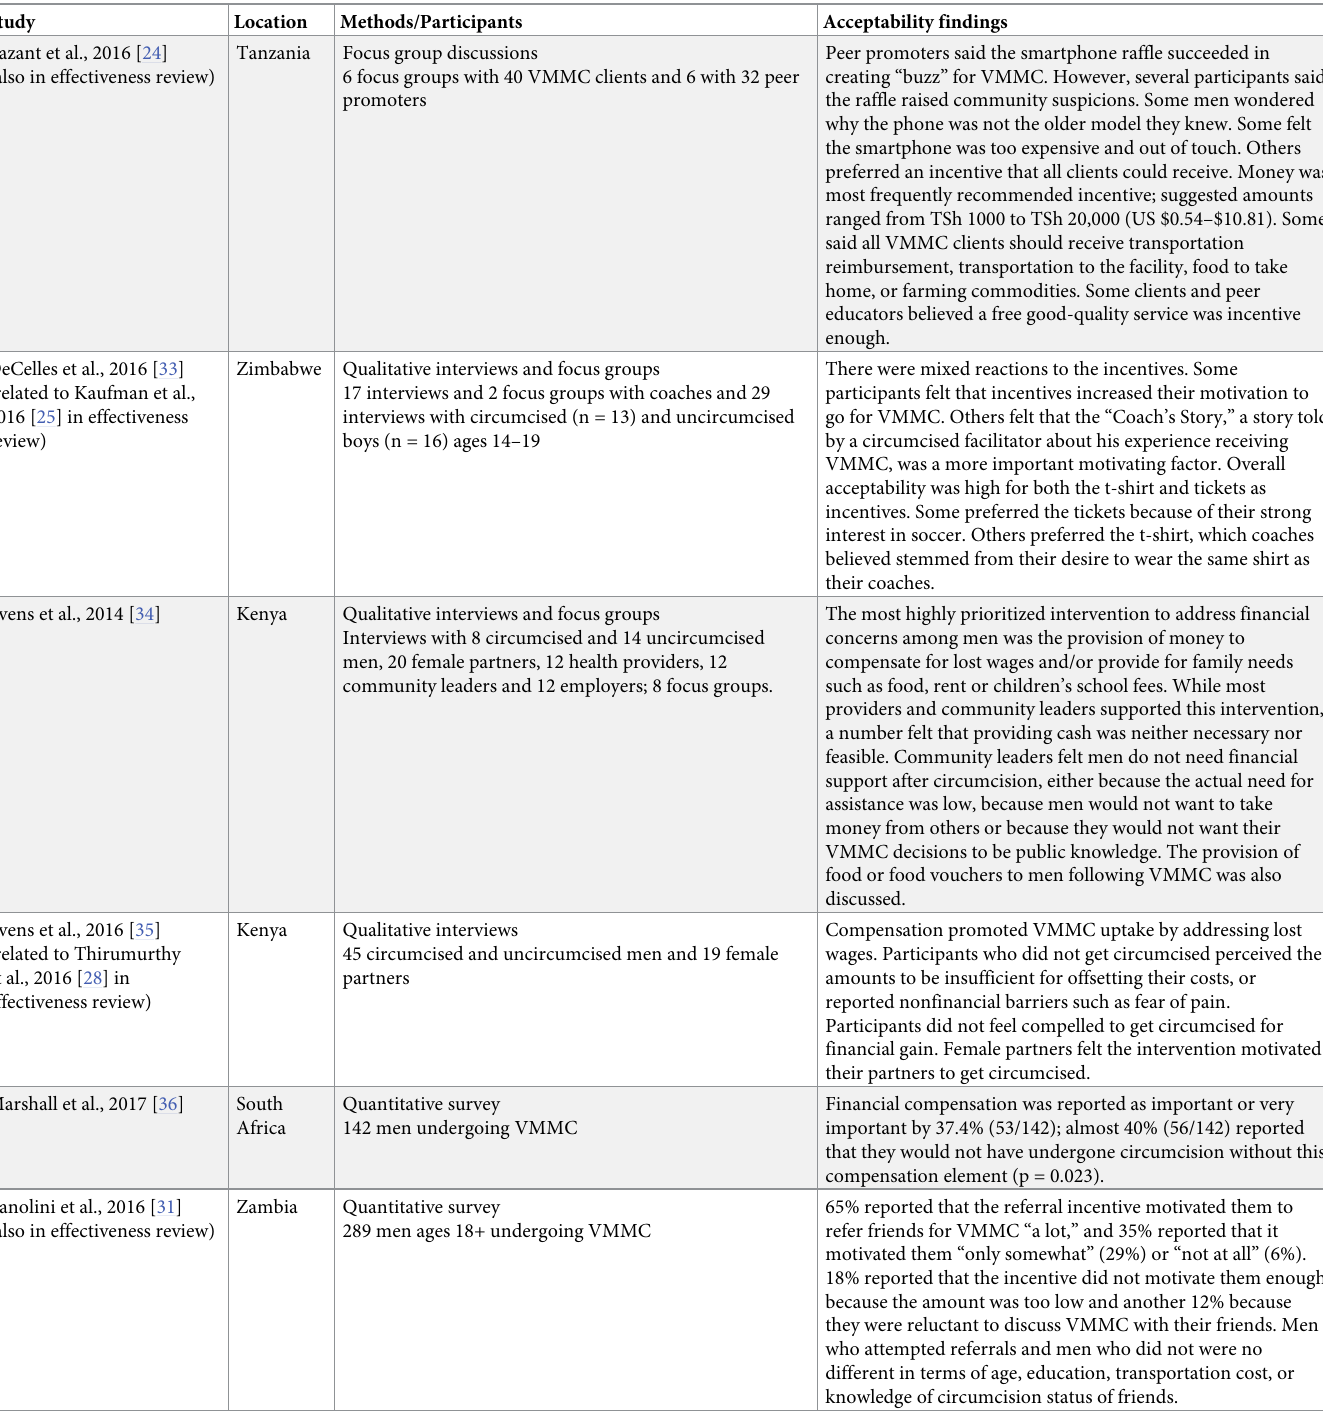
Table 2. Description of included studies–acceptability